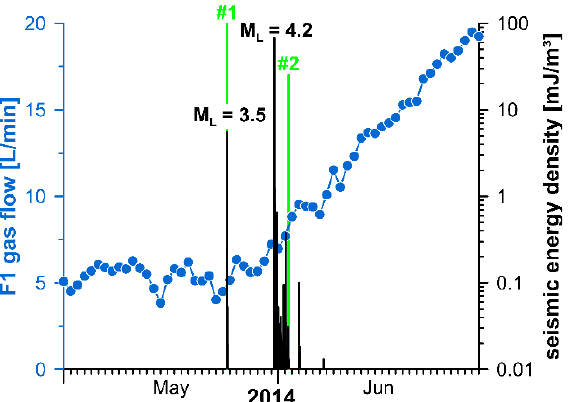
Figure 8. Gas flow rate (daily averages; blue symbols) at F1 during the 2014 earthquake swarm. Seismic energy density (black bars) calculated according to [37] for the site Hartoušov. Vertical green lines indicate two breaking points suggested by the code of [36]: #1 on 23 May and #2 on 2 June 2014 (the height of the green bars is proportional to their relevance).